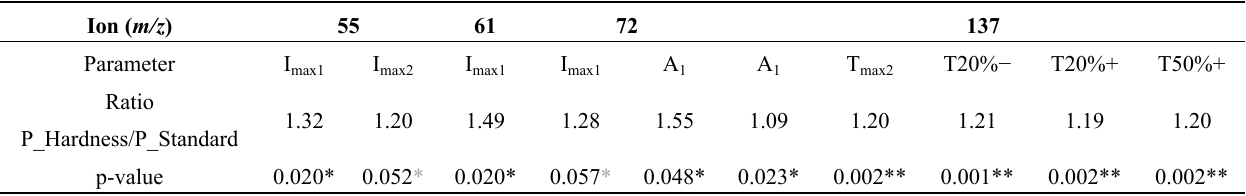
Table 5. Value ratio of characteristic parameters that significantly differ between P_Hardness and P_Standard products. Characteristic parameters were extracted from in vivo release curves (only parameters with significant differences are shown; * trend; * significant at 5%; ** significant at